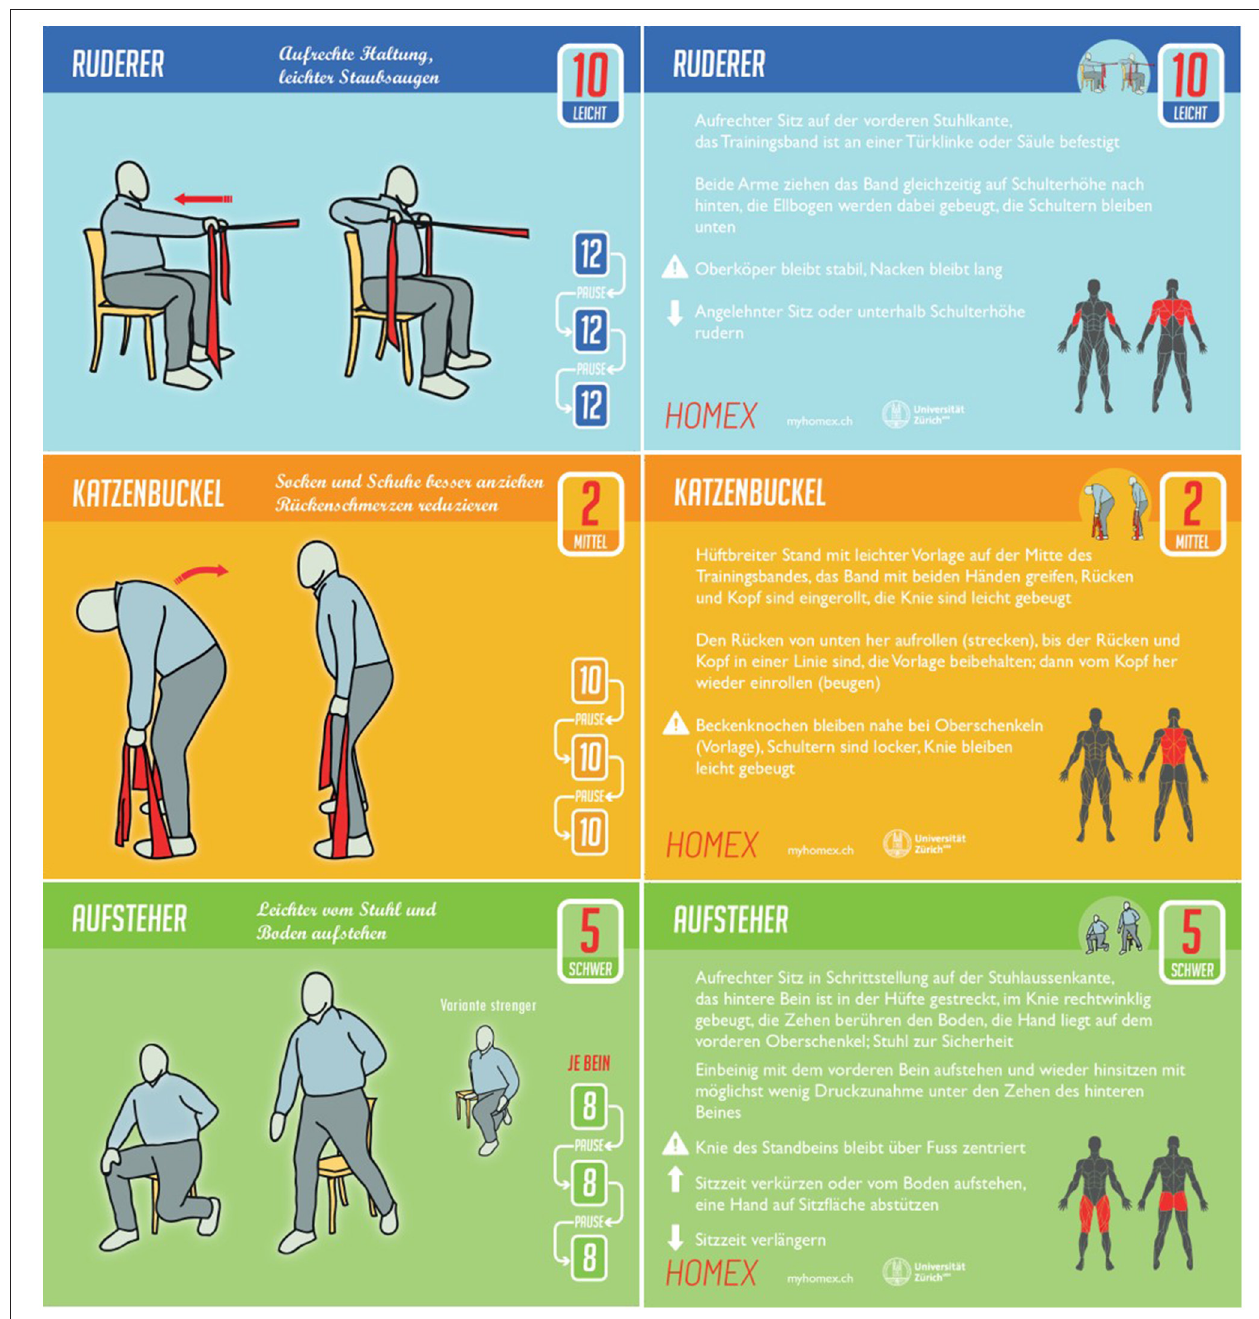
FIGURE 1 | Examples of three exercise